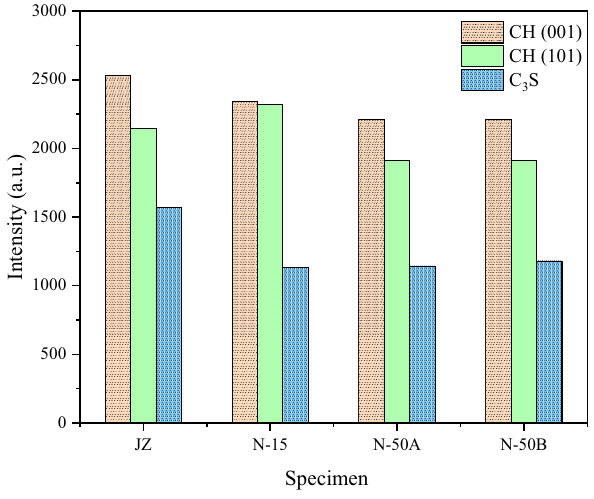
Figure 4: Di ff raction intensity of CH and C 3 S peaks for each specimen at 1 day.